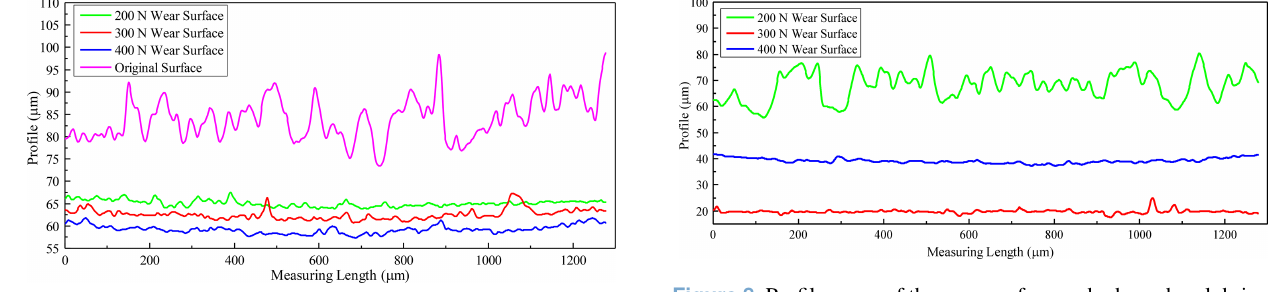
Figure 6. Profile curve of the wear surface under dry friction.